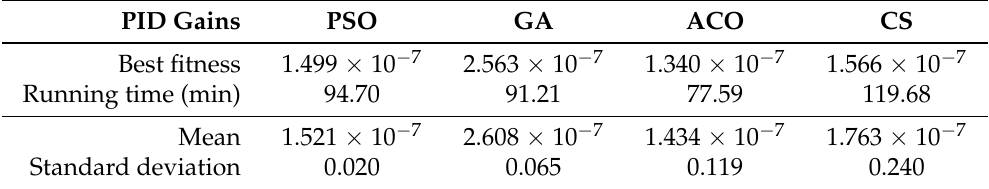
Table 6. The fitness, the running times of the four PID controllers’ gains optimisation algorithms and the mean and standard deviation of the ten experiments